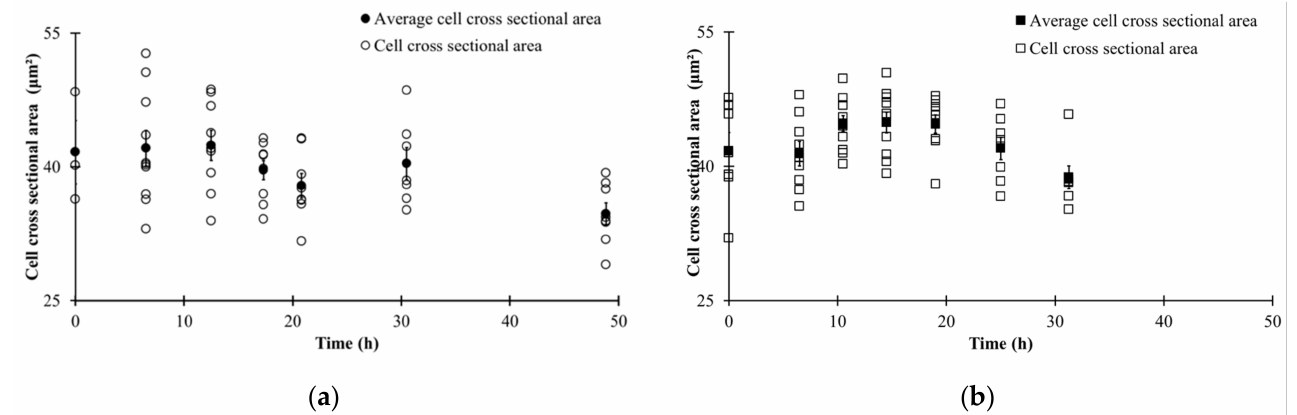
Figure 7. ( a ) Yeast CSA with respect to time at 30 ◦ C; ( b ) Yeast CSA with respect to time at 35 ◦ C. Cross-sectional data are represented as follows: data at 30 ◦ C (empty circles) and 35 ◦ C (empty squares); average data at 30 ◦ C (filled circles) and 35 ◦ C (filled squares). Fermentations and automated image analysis were performed in duplicate. The error bars correspond to the standard error of the data, used to represent the high confidence in the mean associated with a large number of